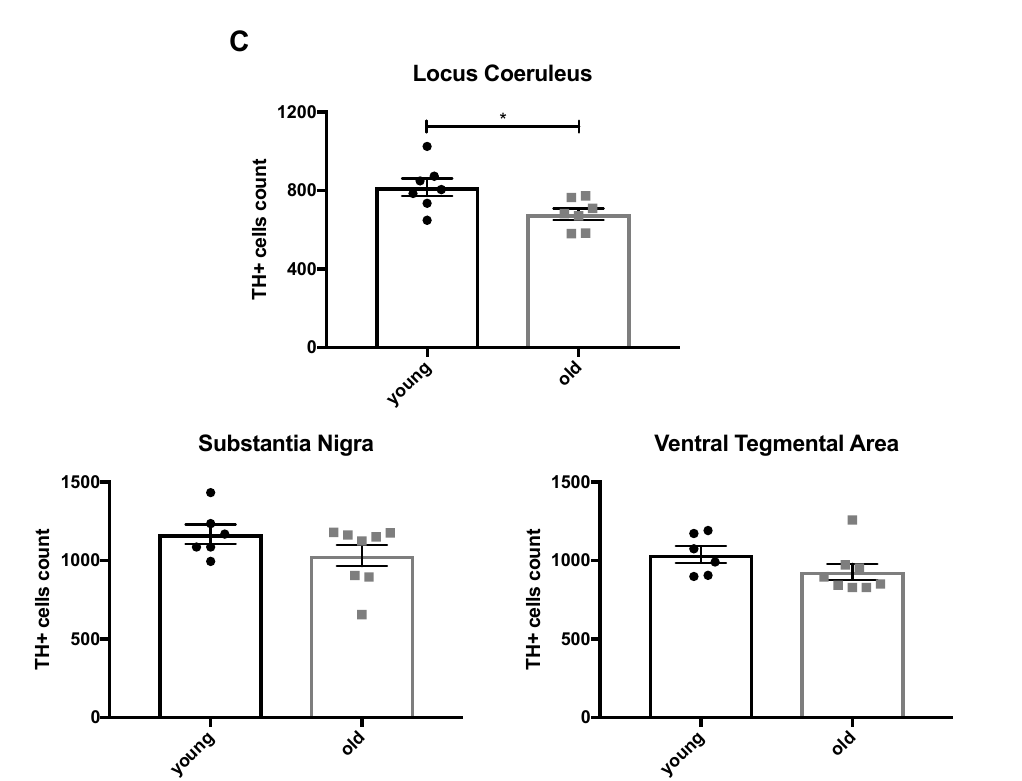
Figure 1. ( A , B ) Representative photomicrographs of the tyrosine hydroxylase (TH)-positive regions locus coeruleus (LC), substantia nigra (SN) and ventral tegmental area (VTA) in young and old animals. ( C ) Quantitative stereological analysis of the total number of TH-positive cells of young (3-month-old) and old (22-month-old) C57BL/6J wild-type mice.* p < 0.05 according to Student’s t -test ( n = 6–8 per age group). Dots represent single animals, columns represent mean values, and error bars represent standard error of means (SEM).